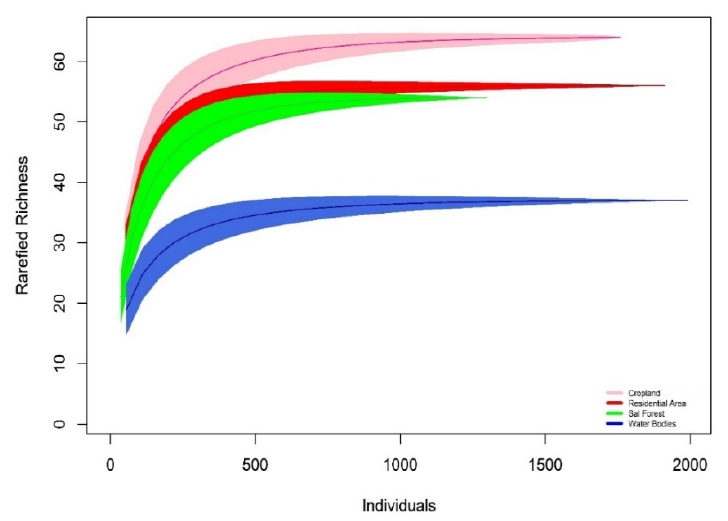
Figure 3. Individual-based rarefaction curve for bird species richness found in four different habitats in the study area. The shaded area around the curve indicates 95% confidence intervals (CI). Seasonally, winter harbored the highest richness (111 bird species; J = 0.85), followed by summer (106 bird species; J = 0.88) and monsoon (94 bird species; J = 0.88). However,